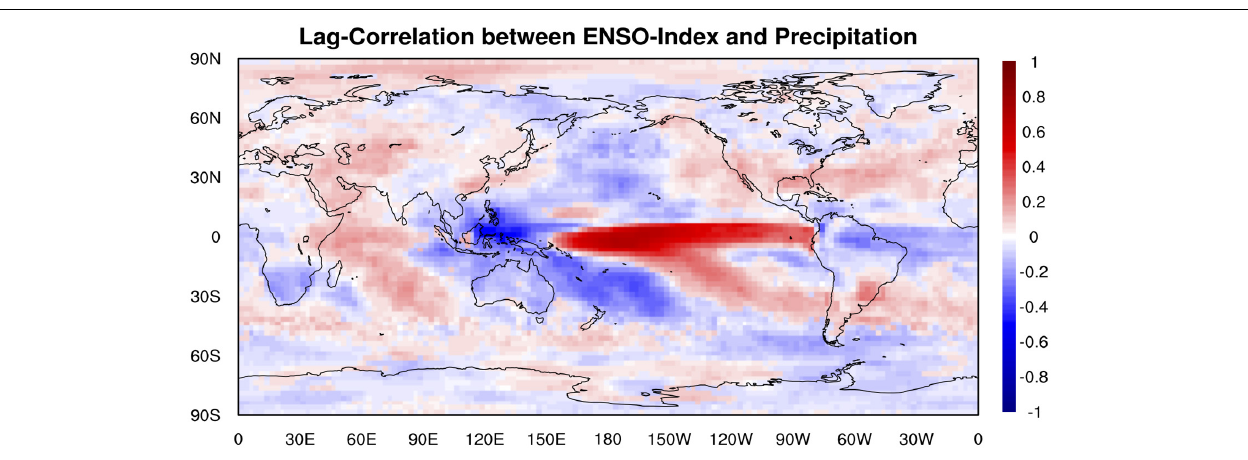
FIGURE 10 | Maximum lag correlation between ENSO index and